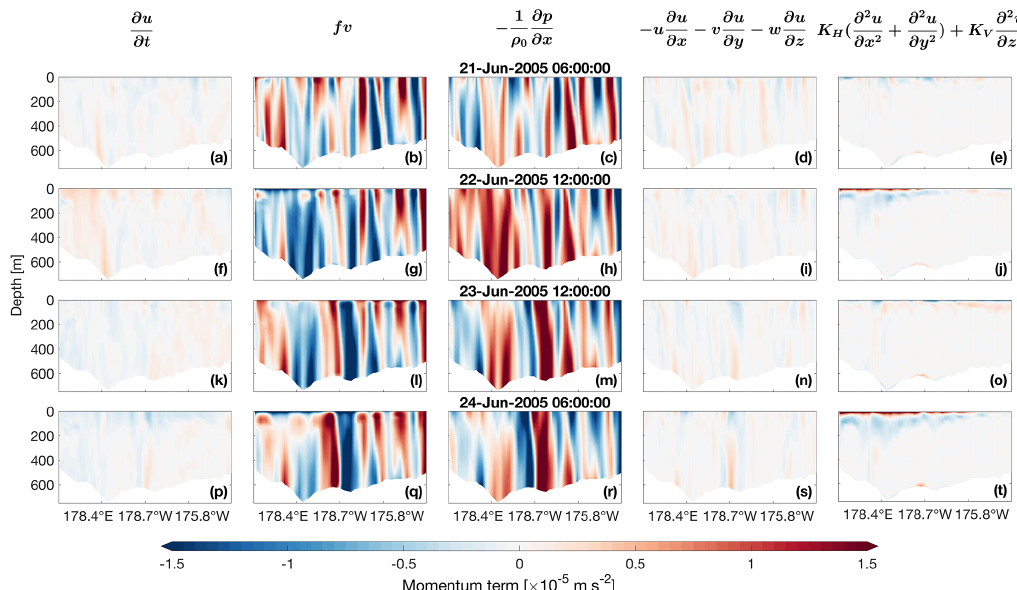
Figure 13. Vertical sections of the momentum equation terms (Eq. 1) along S3 at four selected time moments during the MESO event (indicated by the magenta triangles in Fig. 11a and b): (a, f, k, p) local acceleration, (b, g, l, q) Coriolis acceleration, (c, h, m, r) pressure gradient force, (d, i, n, s) nonlinear advection, and (e, j, o, t) eddy viscosity in the along-ice-shelf momentum